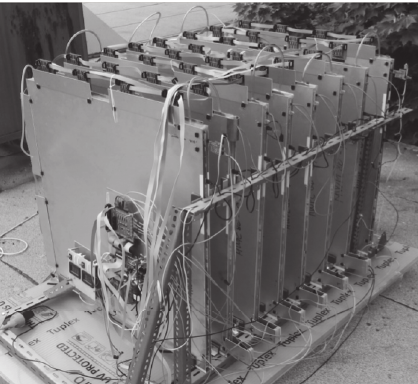
Figure 3: Image of the tracking system setup on the roof installed with vertical detector layers. A light cover box was used in addition to give basic environmental protection.